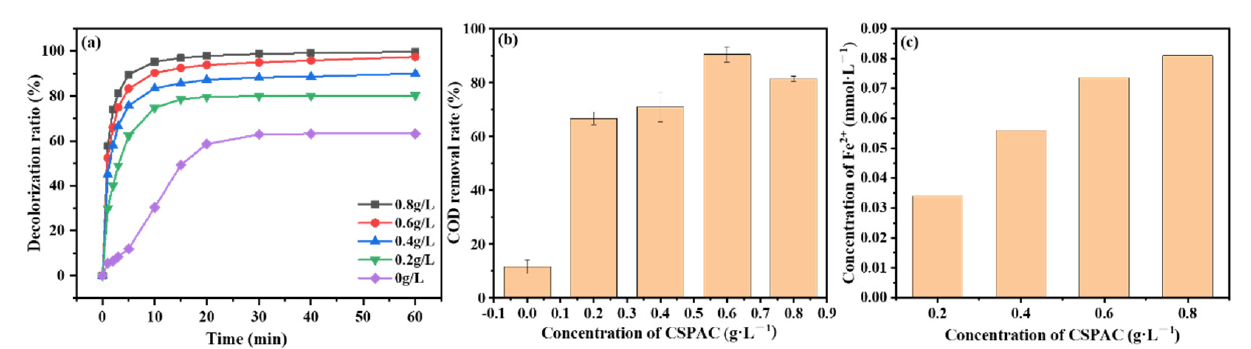
Figure 4. Effect of different CSPAC concentrations on the ( a ) decolorization rate of ARG, ( b ) COD removal rate in the Fe 3+ /H 2 O 2 /CSPAC system (0.1 mmol/L FeCl 3 , 0.2 mmol/L H 2 O 2 , 100 mg/L ARG, 0–0.8 g/L CSPAC (75 µ m particle size), pH = 3), and ( c ) generation of Fe 2+ in the Fe 3+ /CSPAC system (0.1 mmol/L FeCl 3 , 0–0.8 g/L CSPAC (75 µ m particle size), pH = 3).